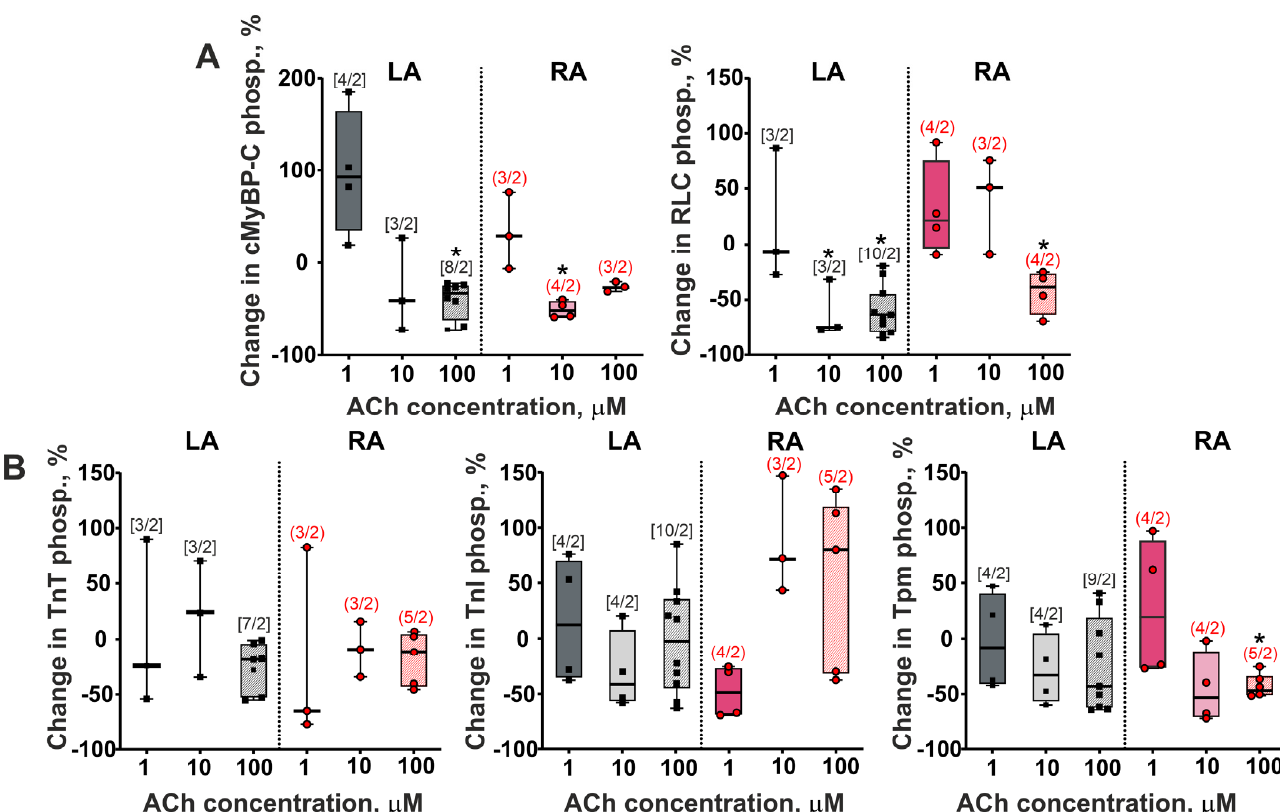
Figure 5. The acute effects of ACh on sarcomeric protein phosphorylation in LA and RA cardiomy- ocytes. cMyBP-C–cardiac myosin binding protein-C; RLC–myosin regulatory light chain; TnT–tro- ponin T; TnI–troponin I; Tpm–tropomyosin. ( A ) Phosphorylation levels of cMyBP-C and RLC. ( B ) Phosphorylation levels of TnT, TnI, and Tpm. The same hearts were used for ACh groups and indi- vidual controls. Phosphorylation is expressed as the ratio of the intensities of protein bands stained with Pro-Q Diamond and SYPRO Ruby, and then calculated as the % change related to the individ- ual control values. The number of n samples from N hearts is shown in square brackets [LA] or parentheses (RA). Data are presented in box and whisker plots, where the boxes are drawn from Q1 to Q3, horizontal lines represent median values and whiskers give the 100% range of the values. * p < 0.05: 1, 10, and 100 µM ACh compared to the individual control group (0 µM ACh), Mann–Whit- ney U-test.